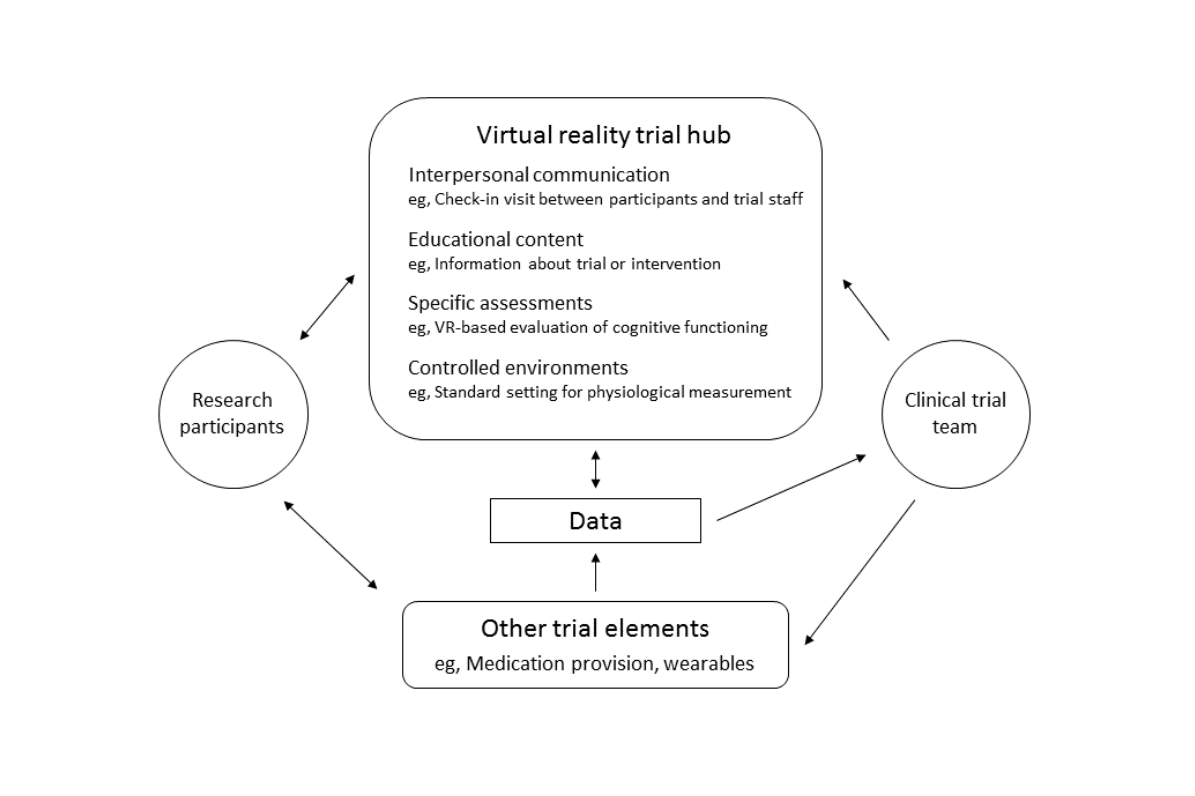
Figure 1. Relationships among virtual clinical trial elements incorporating virtual